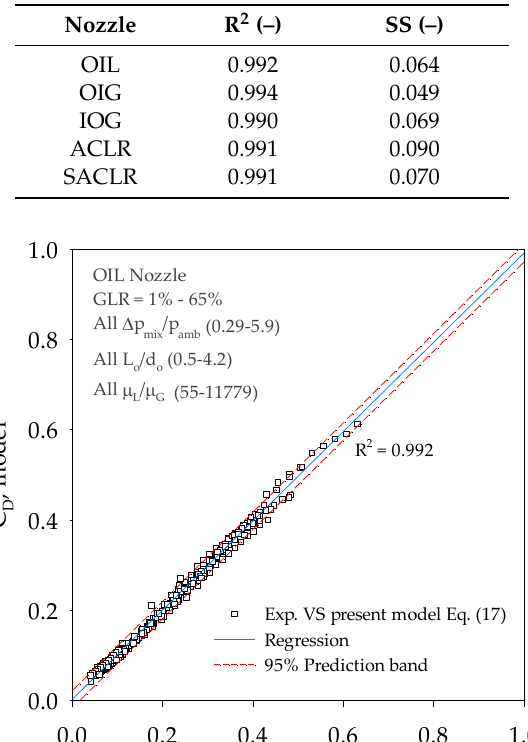
Table 5. Values of R 2 and sum of the squared residuals (SS) for the tested IMTF nozzles in Equation (17).